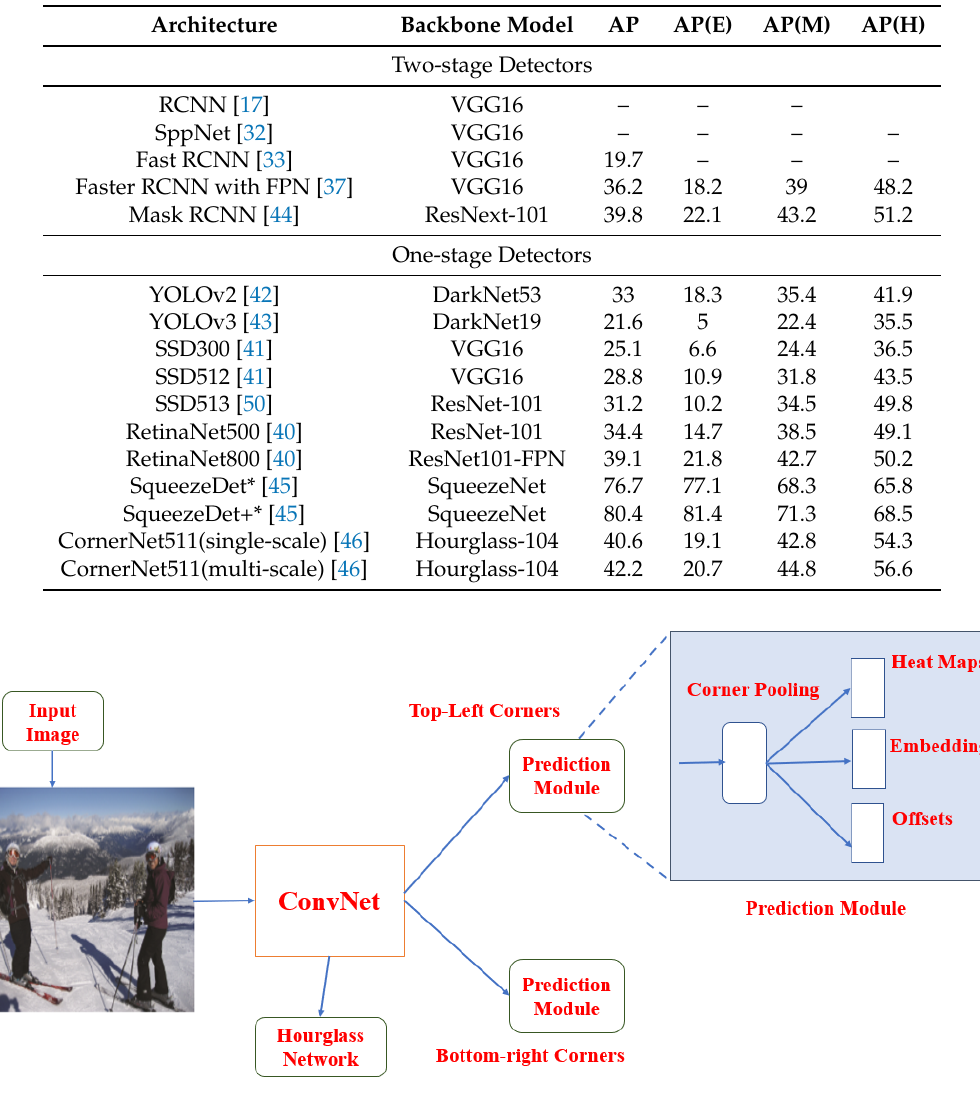
Figure 14. CornerNet architecture